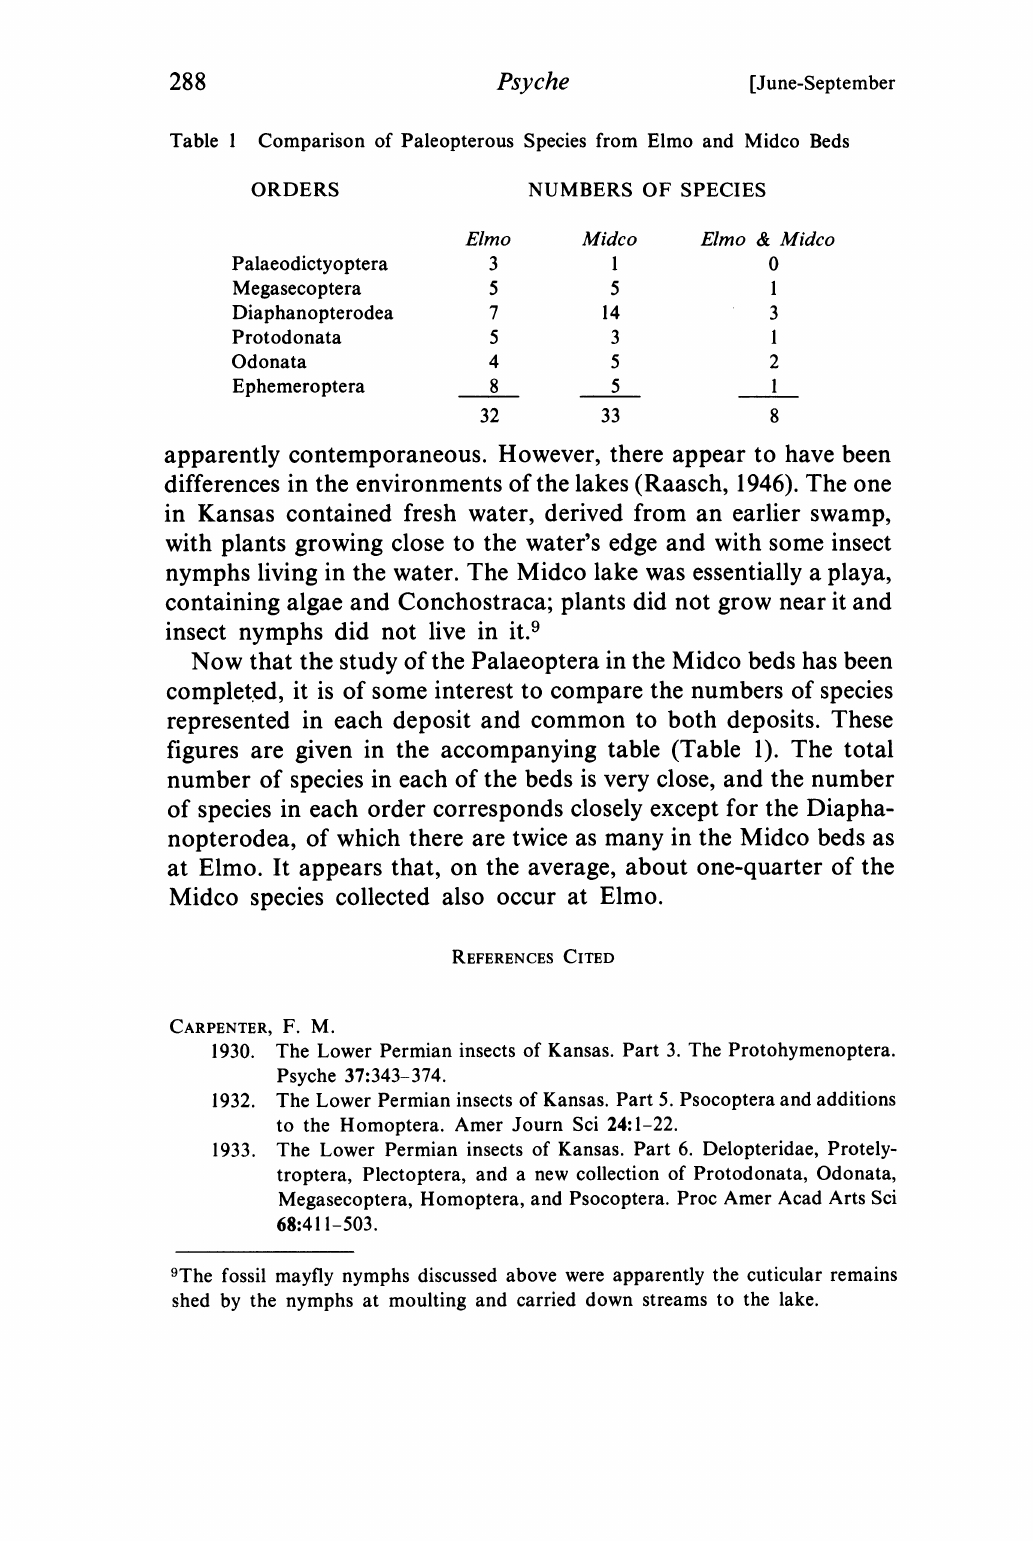
Table Comparison of Paleopterous Species from Elmo and Midco Beds